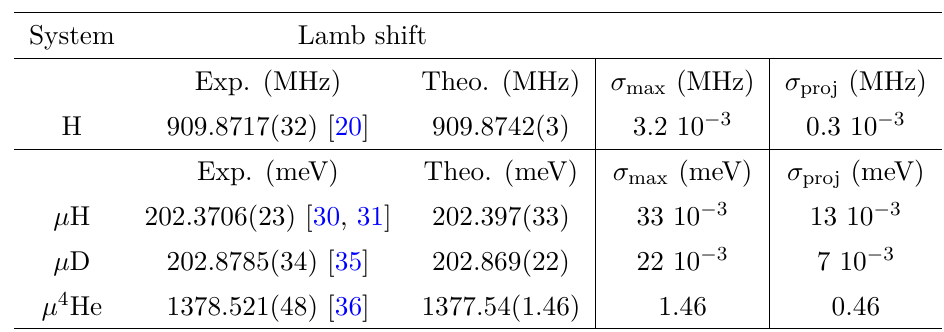
Table 1 . Table for the theoretical and experimental predictions for the Lamb shift in different muonic systems as well as in hydrogen. See the text for references to the theoretical computations and the origin of the projected